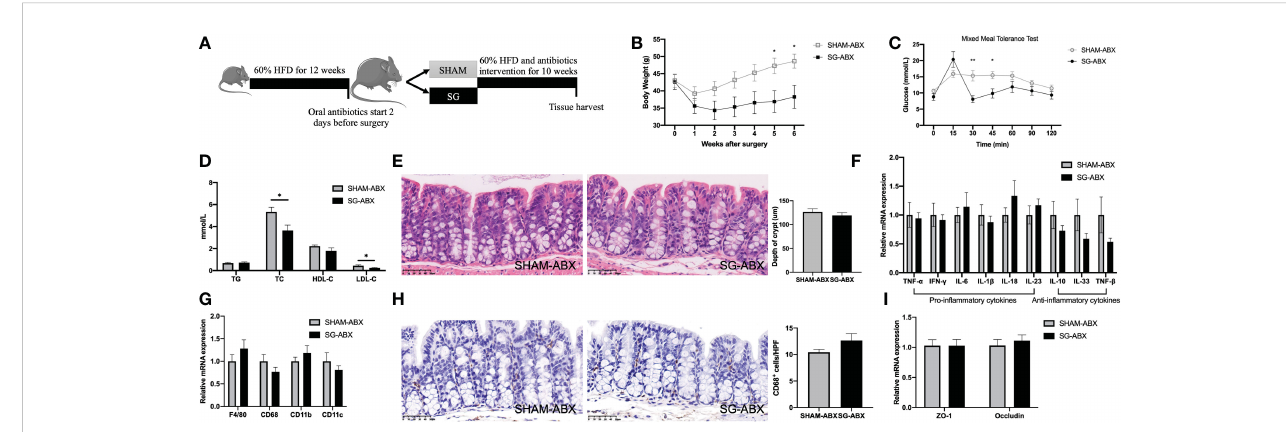
FIGURE 4 Administration of broad-spectrum antibiotics comprises SG ’ s ability to improve HFD-feeding induced colonic pro-in fl ammation. (A) Experimental design and timeline (SG-ABX n=8, SHAM-ABX n=9). (B) Body weight. (C) Mixed meal tolerance test (MMTT). (D) Serum lipids. (E) Representative H&E-staining images of colon (400x; scale bar, 50 um) and quanti fi cation of depth of crypt. (F) Genes expressions of in fl ammatory cytokines in the colon. (G) Gene expressions of macrophages markers in the colon. (H) Representative histological images of colon stained with anti-CD68 antibody (400x; scale bar, 50 um) and quanti fi cation of CD68 positive cells. (I) Gene expressions of tight junction proteins in the colon. n = 8/group; Data are presented as means ± SEM. Two-way ANOVA with post hoc Sidak test for multiple comparisons (B, C) and Student ’ s t-test (D – H) were used for signi fi cance assessments. **P < 0.01, *P < 0.05. SHAM, sham surgery; SG, sleeve gastrectomy; ABX, antibiotics.